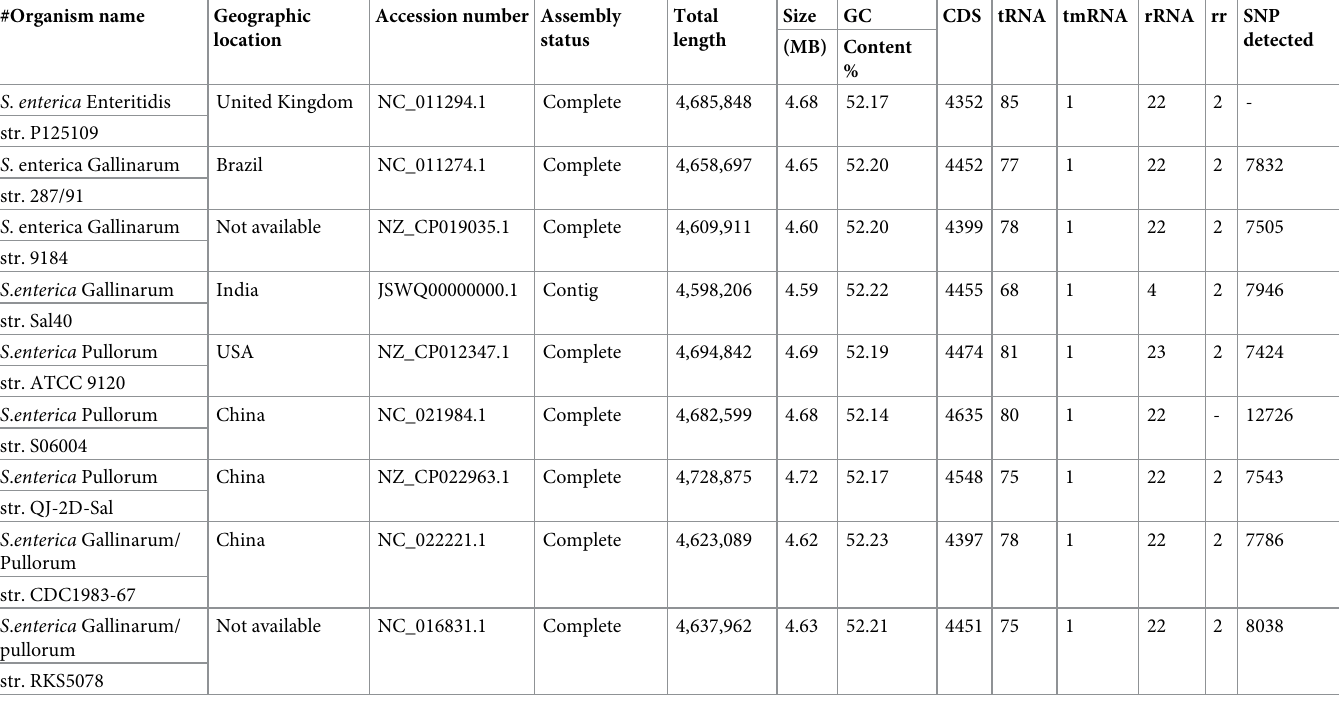
Table 1. Genome statistical information of nine investigated Salmonella strains as obtained by Prokka pipeline and ANI